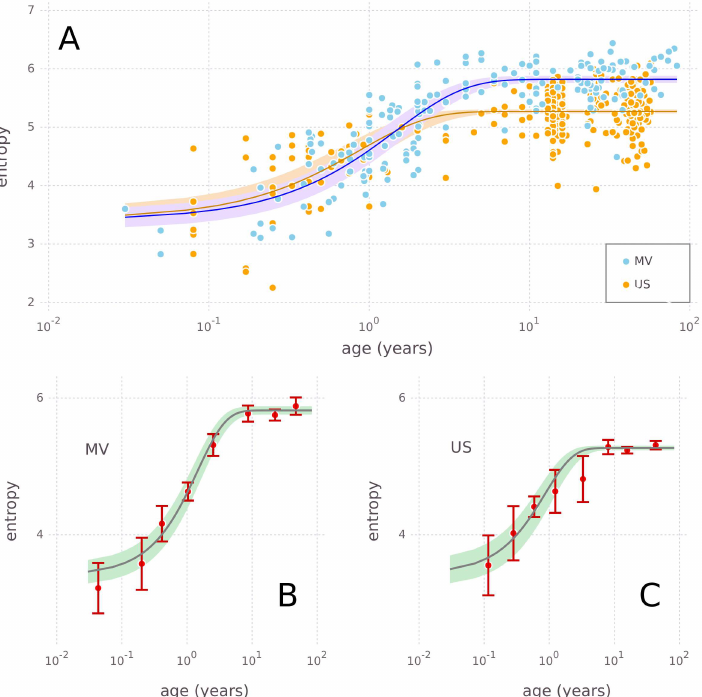
Fig 9. Development of gut microbiome entropy H R with age t . (A) Entropies H ð i Þ 181 samplesfrom Malawi and Venezuela (MV, blue dots), and 308 samples from the United States (US, orangedots). Log-scaledhorizontal axis is age in years. Superimposedare models for H MV ð t Þ (orange line) accordingto Eq (6). Areas aroundthe model lines shaded in blue and orangeare the H US R corresponding 90% confidenceintervalsof the respectivemodels. (B) and (C) Comparisonof mean entropies of measureddata (red points) and their corresponding90% confidenceintervals (error bars), with the model (solid gray lines) and its 90% confidenceinterval(shadedareas), for MV (panelB) and US (panelC). Model lines and shaded areas are the same as in panel A.